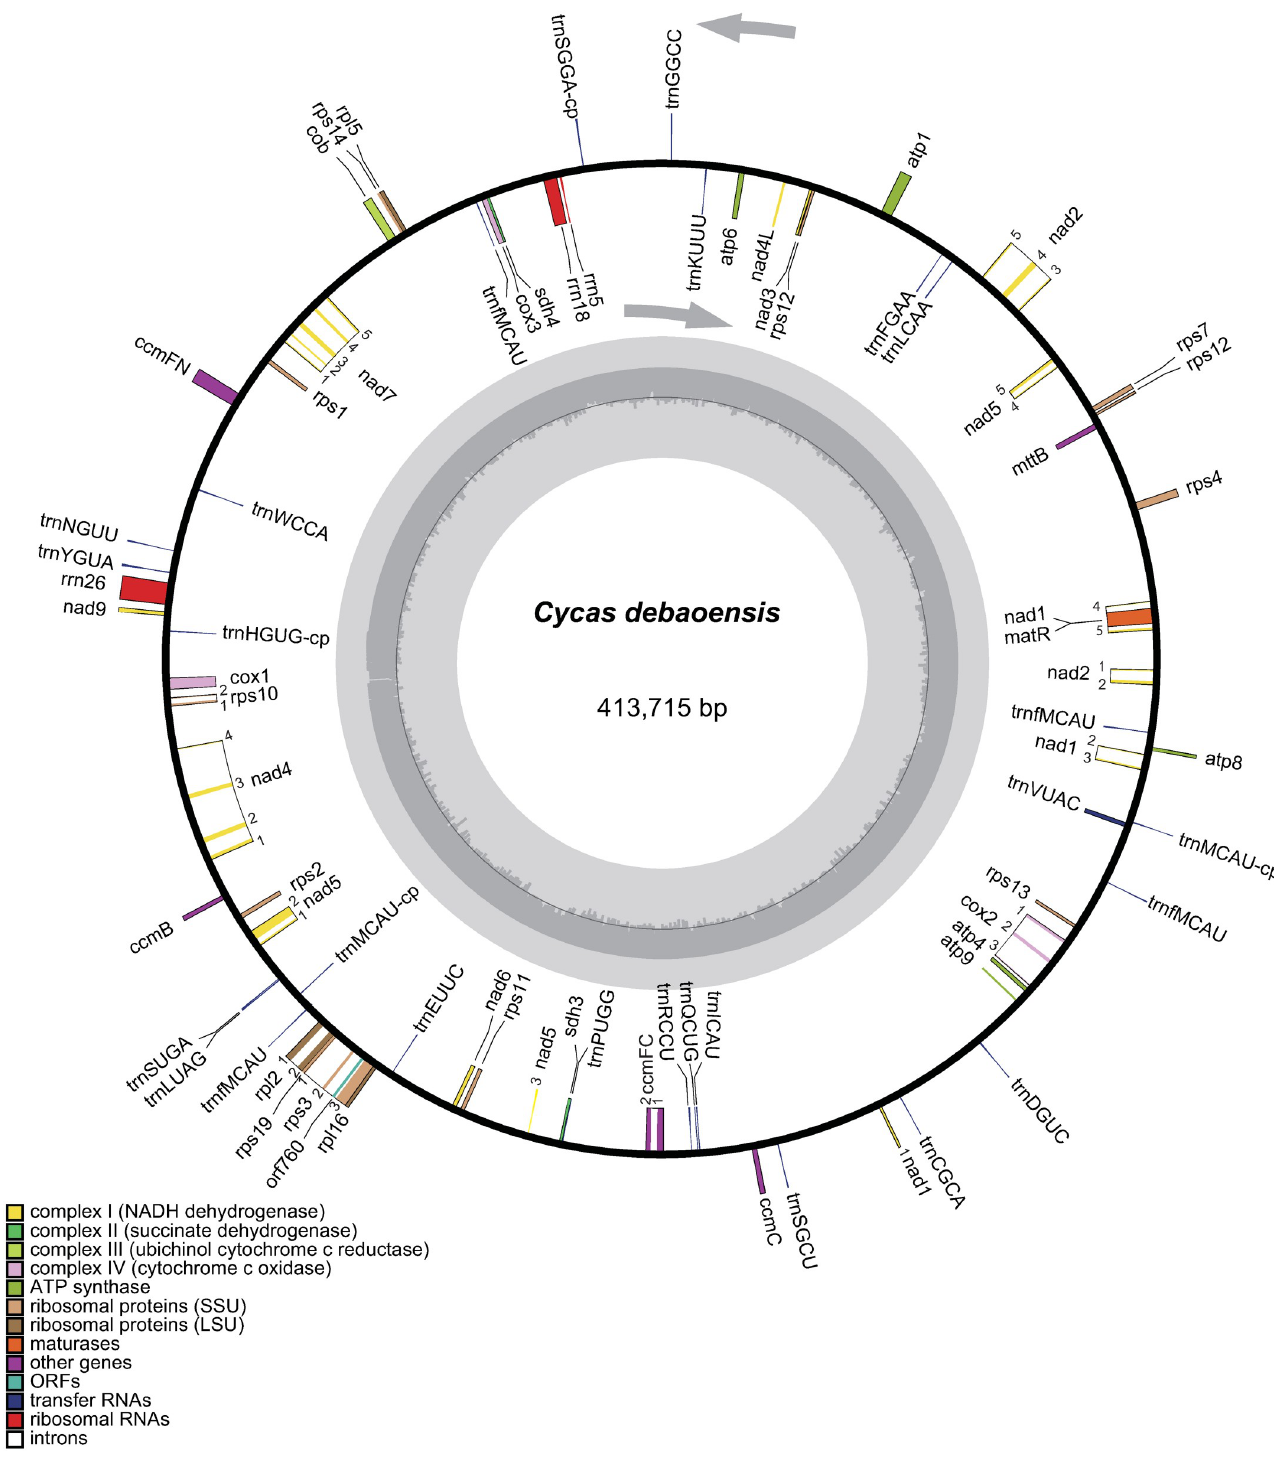
Fig 1. The map of mitochondrial genome of Cycas debaoensis . Genes (along with exon numbers) shown inside and outside of the circle are transcribed in clockwise and counter-clockwise directions, respectively. Plastid derive tRNAs are indicated with a ‘-cp’ suffix.